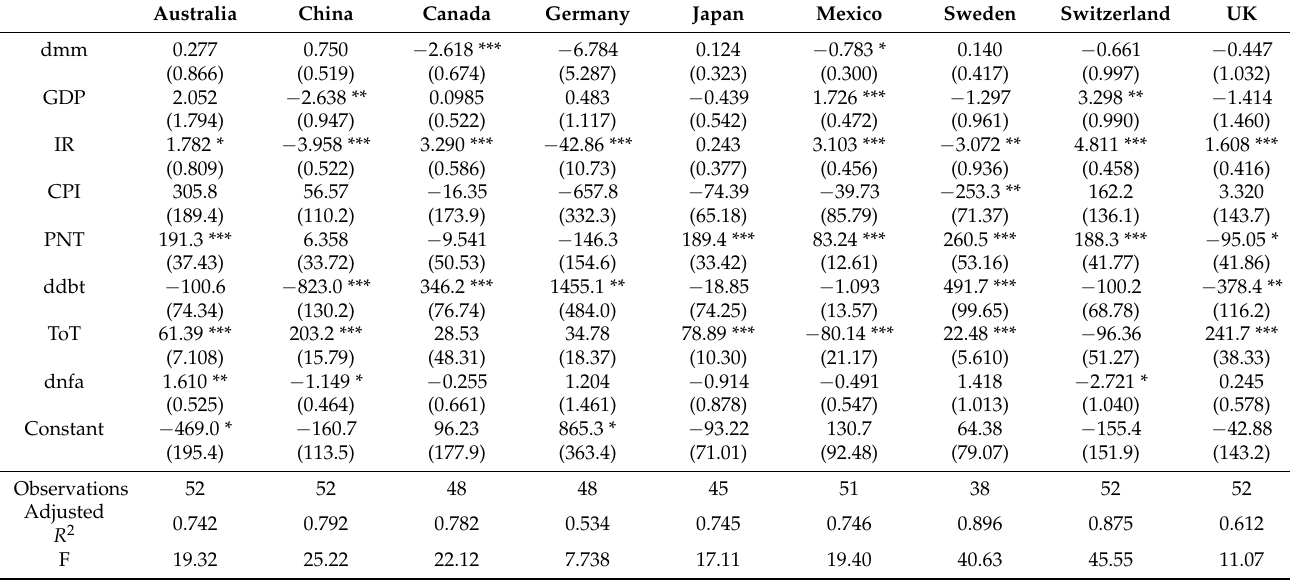
Table A22. Panel Regression AM Model for Countries.